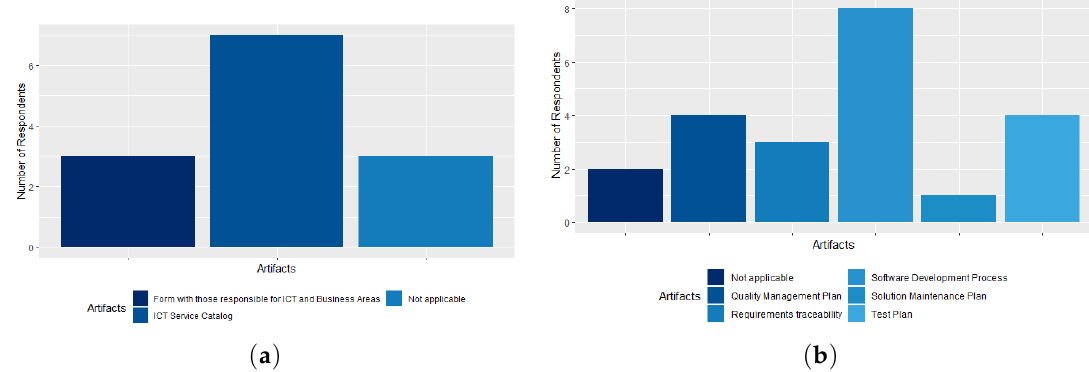
Figure 10. ( a ) The ICT Risk Management process artifacts; ( b ) the ICT Goods and Services Contracting process (Manage Software Acquisitions)